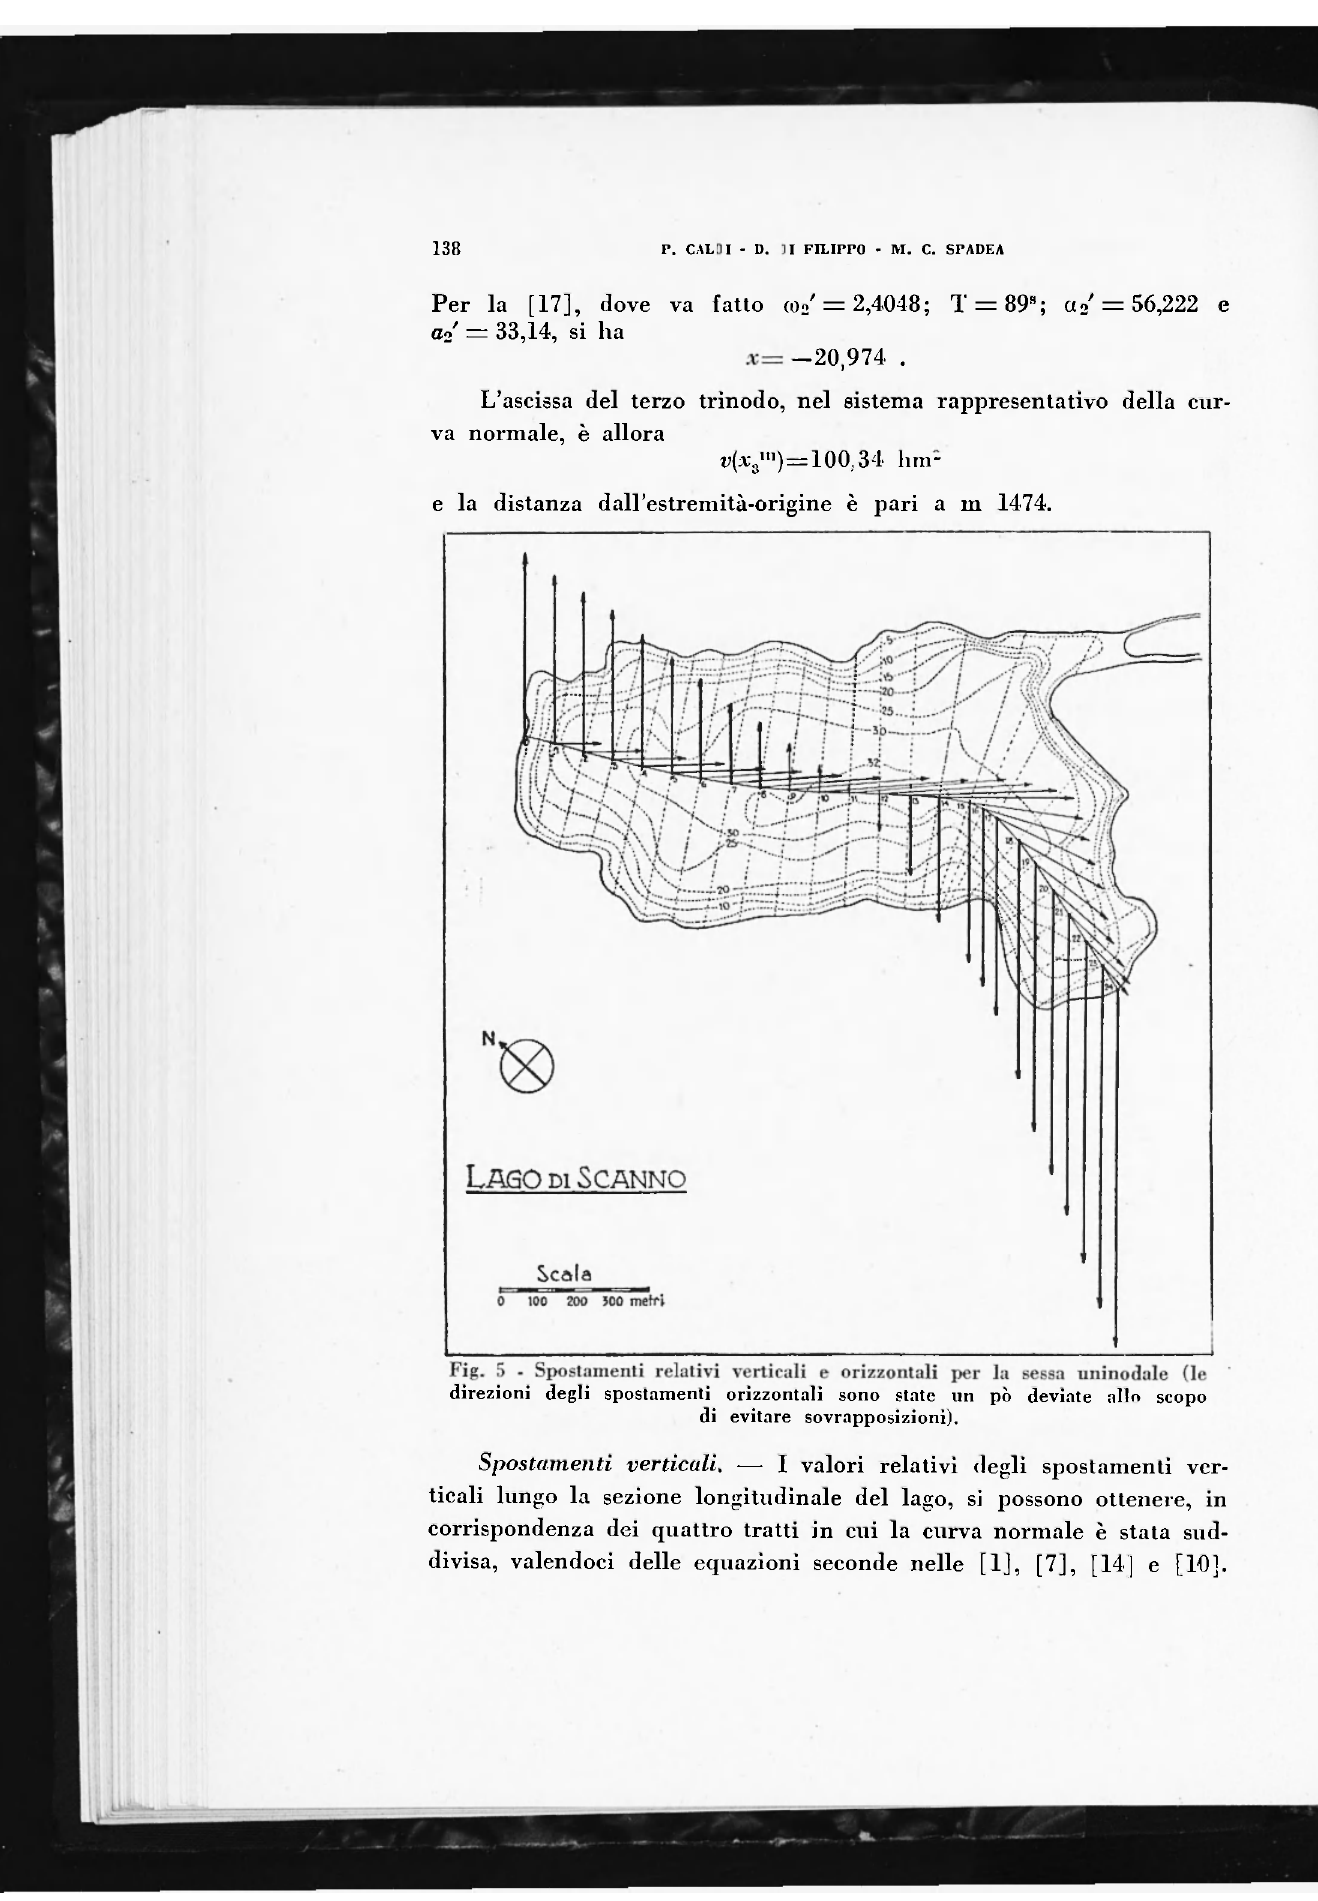
Spostamenti verticali. — I valori relativi degli spostamenti